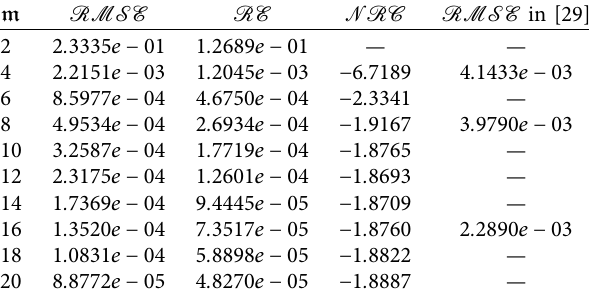
Table 2: RMSE , RE , and NRC for diferent m for Example 2.